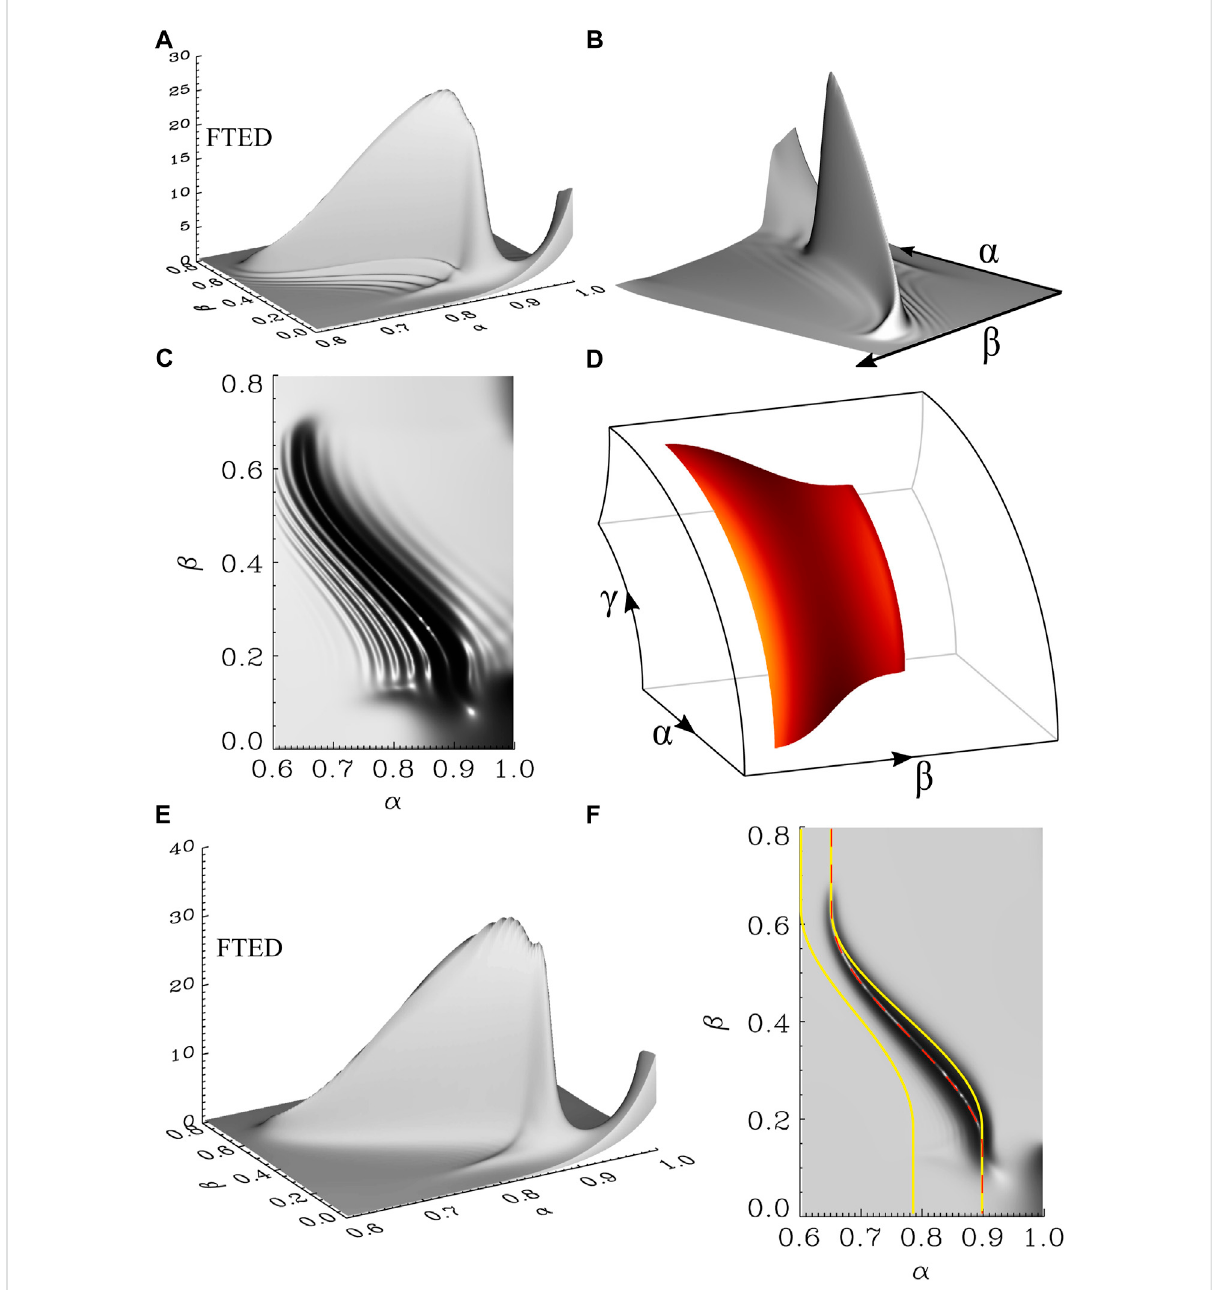
FIGURE 5 Composite of Figures 4, 5, Elsden and Wright (2017). (A) Shaded surface of fl ux tube energy density (FTED) at an early simulation time. (B) Rotated view of (A) . (C) Aerial view of (A) . (D) Surface of resonant fi eld lines (orange) in real space within the dipole simulation domain skeleton. (E) Shaded surface of FTED for a later simulation time. (F) Aerial view of (E) together with the Resonant Zone boundaries (yellow) and favoured resonant path (red